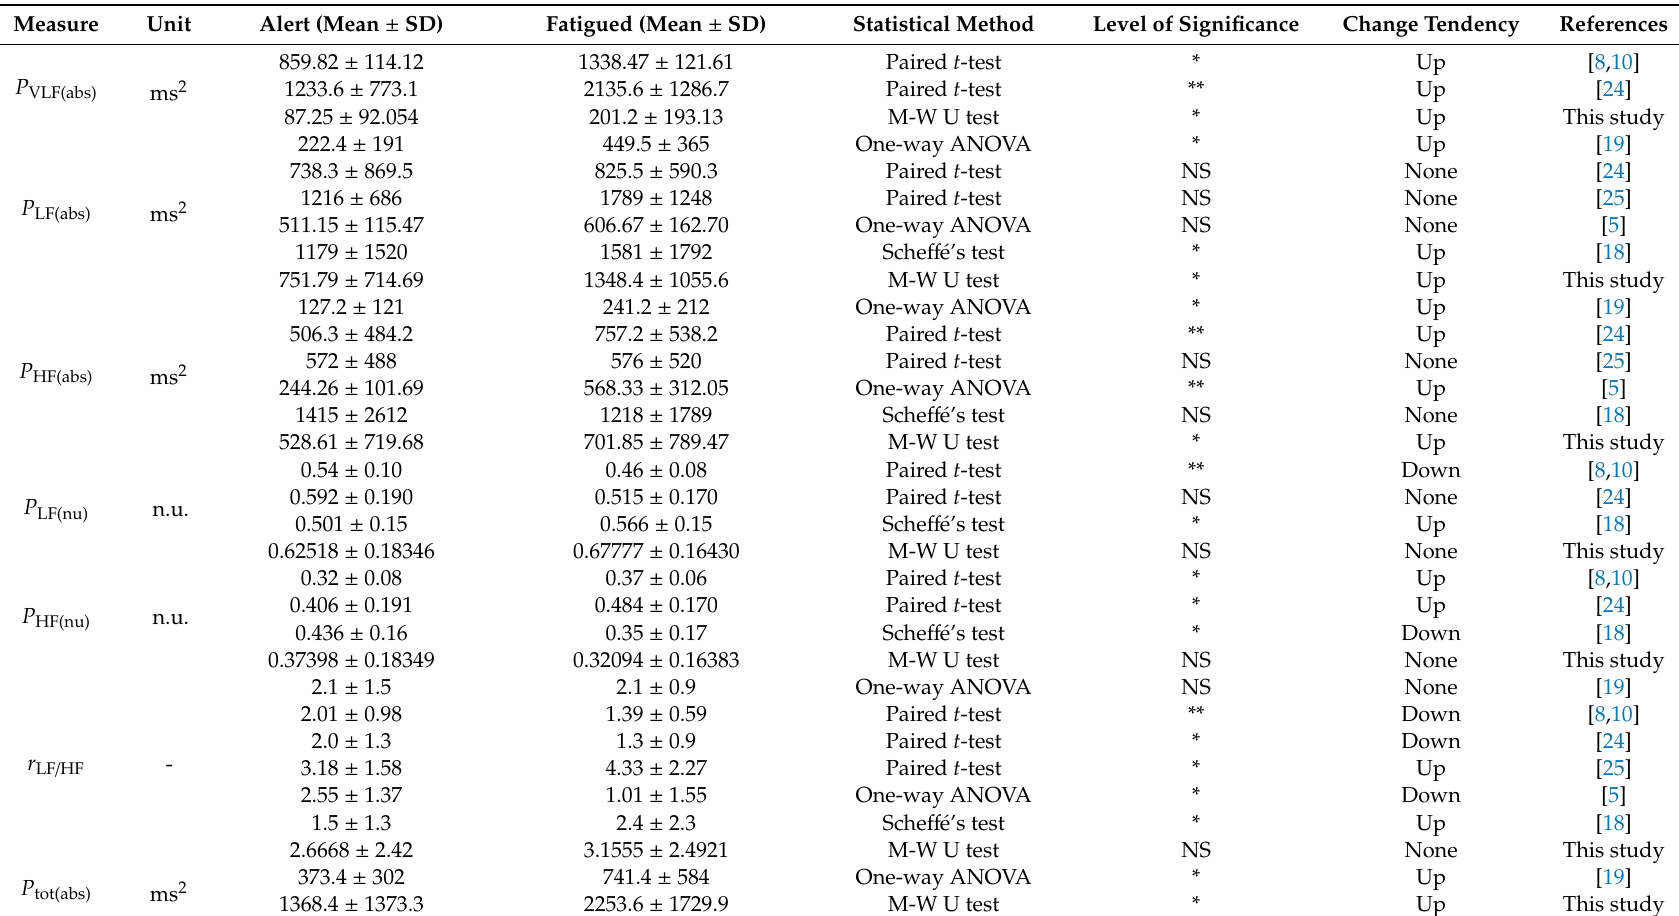
Table 8. Research results related to the HRV frequency domain measures of drivers in di ff erent mental